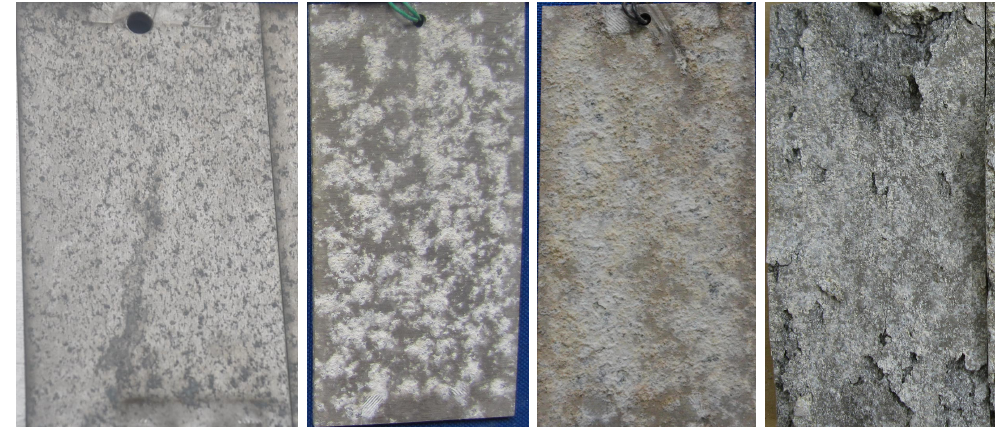
Figure 6. Images from aluminum alloy surface dataset, containing defect type ( left to right ): corrosion spot, corrosion product, corrosion pit and chemical